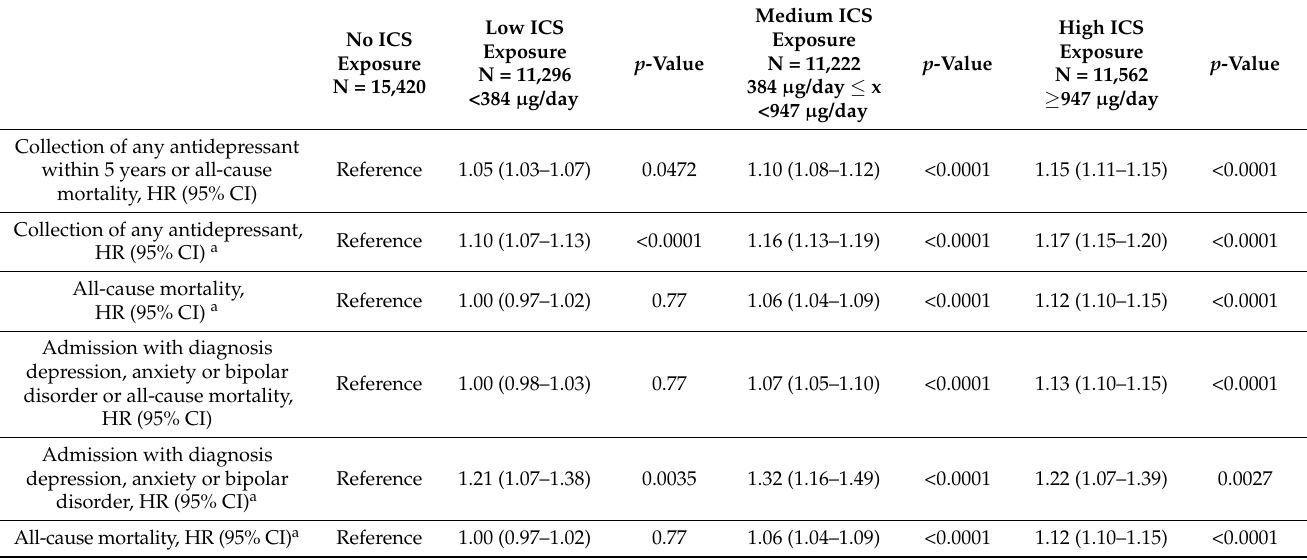
Table 2. Outcomes within 5 years of cohort